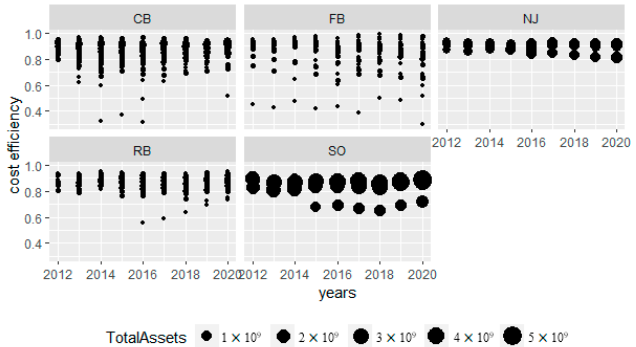
Figure 5. Cost efficiency of different types of banks. Source: author’s preparation. Notes: ordinate axis − the average value of efficiency for the group of banks; abscissa axis − years; categories − groups of banks according to Table 4, where the size of the marker characterizes the size of bank assets, and its representation corresponds to the scale “Total Assets” at the bottom of the fi gure.